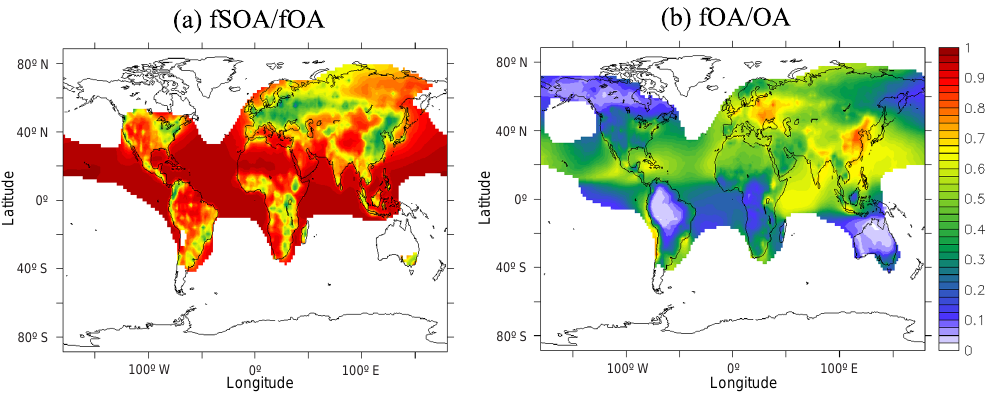
Figure 5. Predicted ratio of (a) fuel combustion SOA (fSOA) to total fuel combustion OA (sum of fPOA and fSOA) and (b) fuel combustion OA to total OA (sum of fOA, bbOA, aSOA, and bSOA) during the years